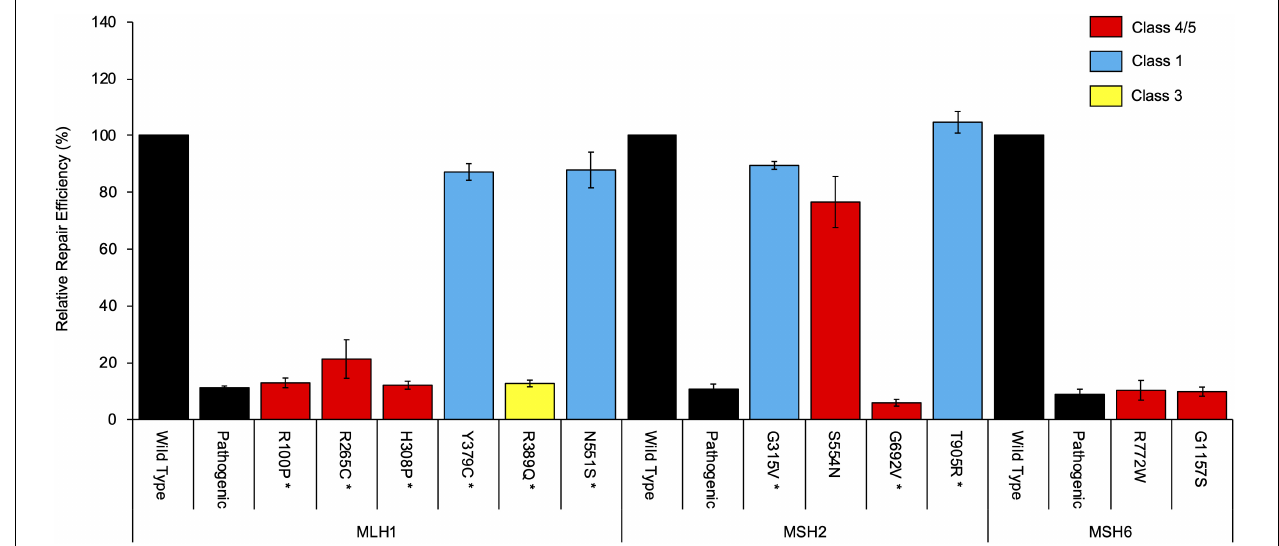
FIGURE 1 | Cell-free in vitro mismatch repair activity (CIMRA) assay results for 12 missense substitutions. The MLH1 p.G67R, MSH2 p.A636P, and MSH6 p.G1139S variants are included in every experiment as repair-deficient (pathogenic) controls. Bars represent mean ± SEM of 3–4 experiments. Asterisks indicate substitutions where the CIMRA assay results converted to a functional LR contributed to the final classification of the variant. The color code (red, blue, yellow) refers to the classification of the variants as determined in this